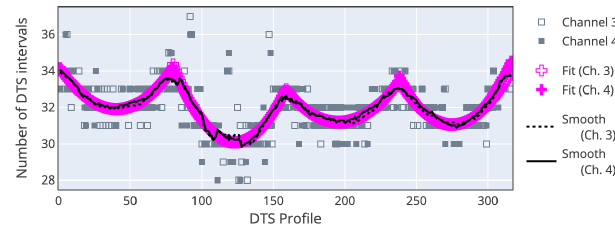
Figure A3. The alignment of DTS profiles was validated using a fit (hyperbole cosine) and smoothing (Savitzky–Golay) function.